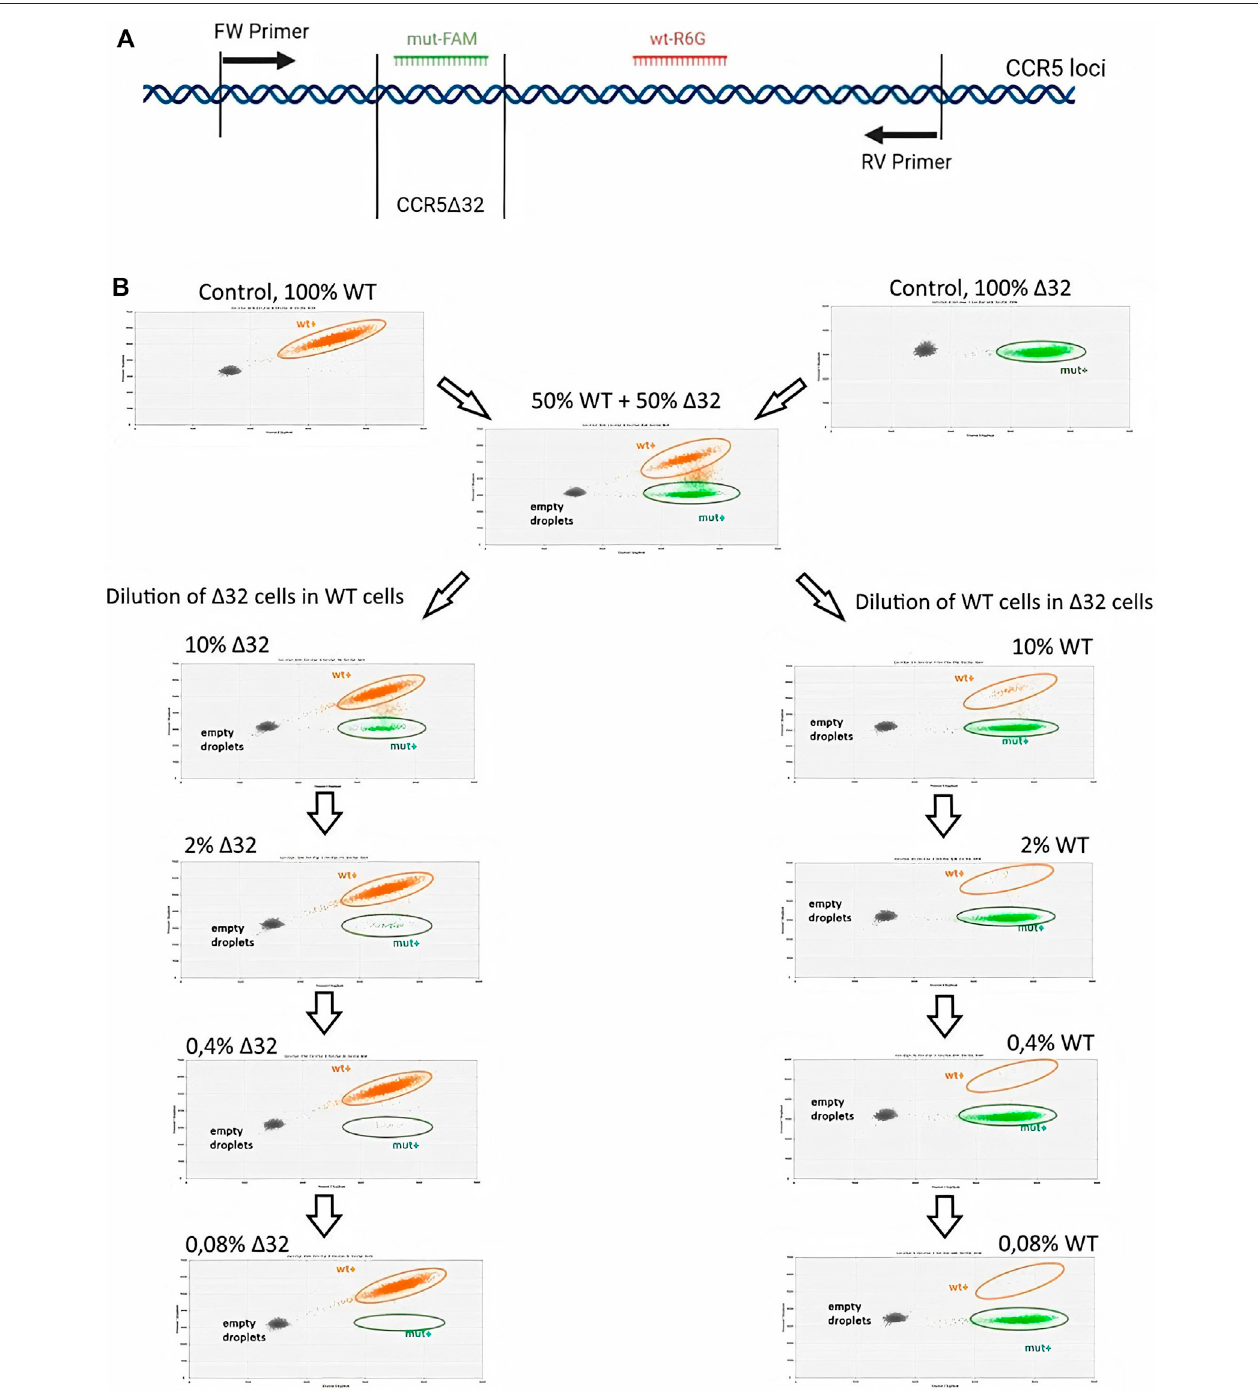
FIGURE 2 | Sensitivity testing of the ddPCR assay for CCR5 alleles detection in MT4 cell mixtures after serial dilution (A) Schematic representation of the primers and FAM or R6G labeled probe hybridization arrangements (B) 2-D visualization of ddPCR results of MT4-14 cell line dilution, Δ 32 cells in wild-type cells (the left-hand column) and wild-type cells in Δ 32 cells (the right-hand